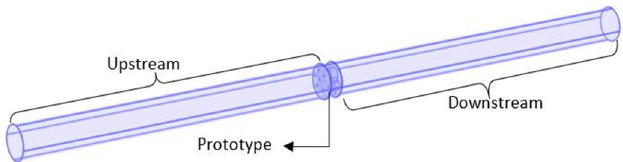
Figure 6. COMSOL model of the metamaterial fitted in cylindrical cavity.